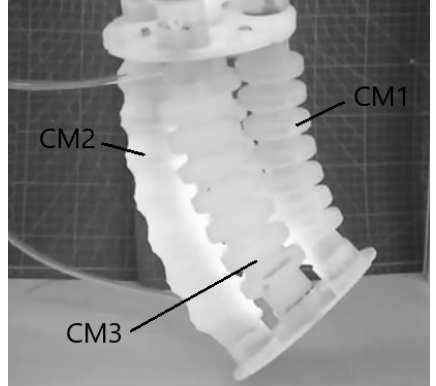
Figure 6. The bending state of different chambers when the manipulator moves.